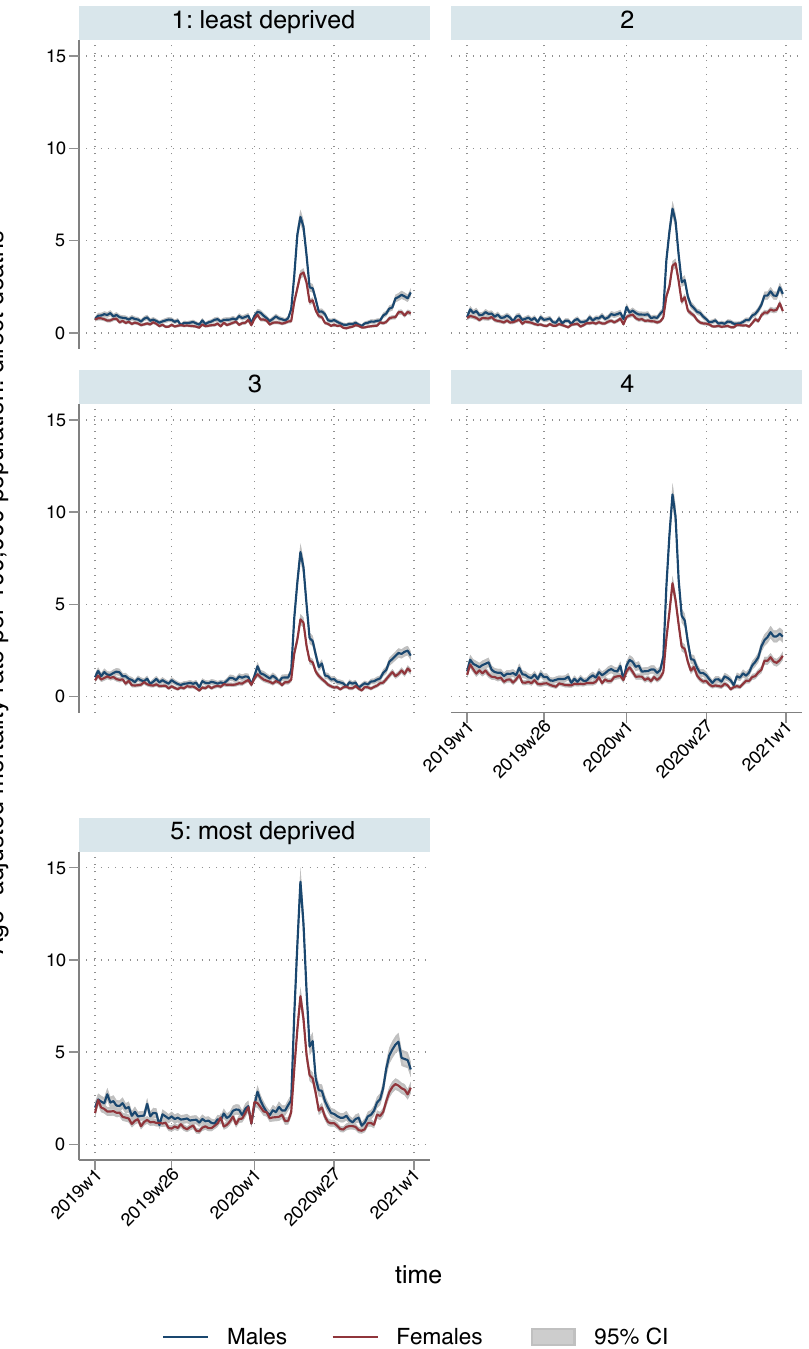
Fig 3. Temporal patterns in ASMRs per 100,000 population for direct deaths, by sex and deprivation quintile. ASMR, age-standardised mortality rate. older people more prevalent in more affluent locations [22]. For ages 45 to 64: 3.31 (95% CI: 2.99 to 3.65); 65 to 74: 2.86 (95% CI: 2.65 to 3.07); 75 to 84: 2.42 (95% CI: 2.27 to 2.59); 85+: 1.63 (95% CI: 1.53 to 1.74). Assuming estimated excess respiratory YLL were only distributed